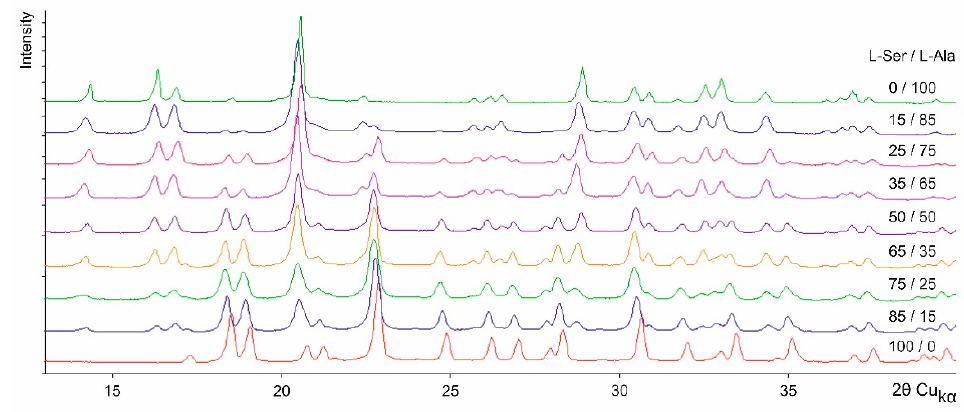
Figure 3. X-ray patterns (2 θ Cu K α ) of co-precipitated mixtures (mol. %): L-ser/L-ala = 0/100, 15/85, 25/75, 35/65, 50/50, 65/35, 75/25, 85/15, and 100/0.